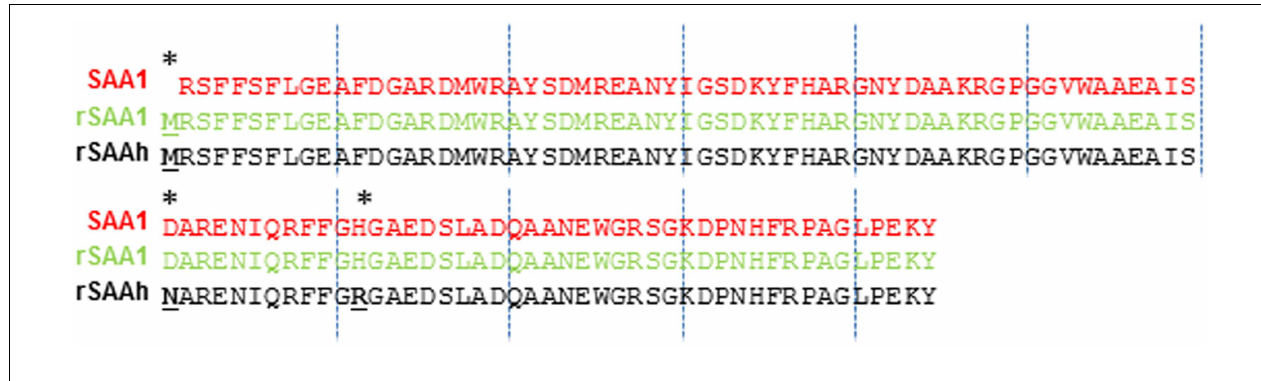
SAA2): asparagine for aspartic acid at position 60 and arginine for histidine at position 71 (marked by asterisks). Recombinant SAA1 is identical to endogenous SAA1 except for the presence of an N-terminal methionine.